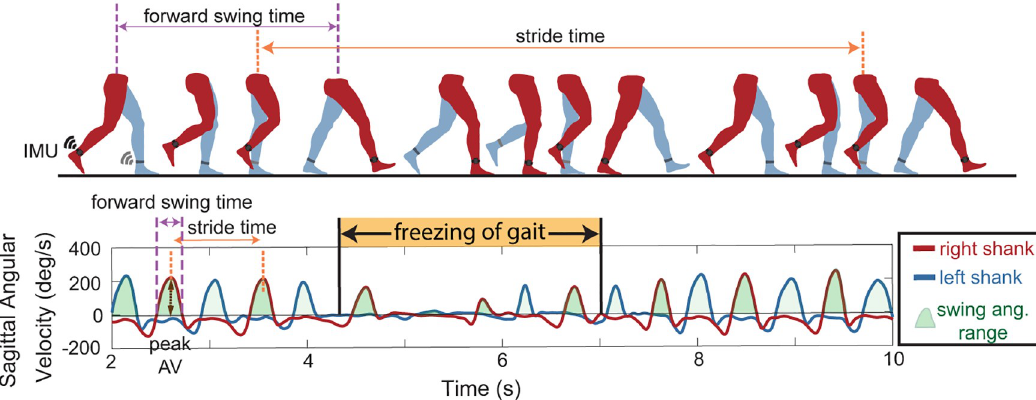
Fig 2. Gait parameters extracted from inertial measurement units (IMU). Top : schematic of one gait cycle with IMU on the shank used to define gait parameters including stride time, forward swing time, swing angular range and peak angular velocities (peak AV). Bottom : gait parameters extracted from shank sagittal angular velocity data for the left (blue) and right (red) legs during periods of non-freezing walking, and freezing of gait (orange).